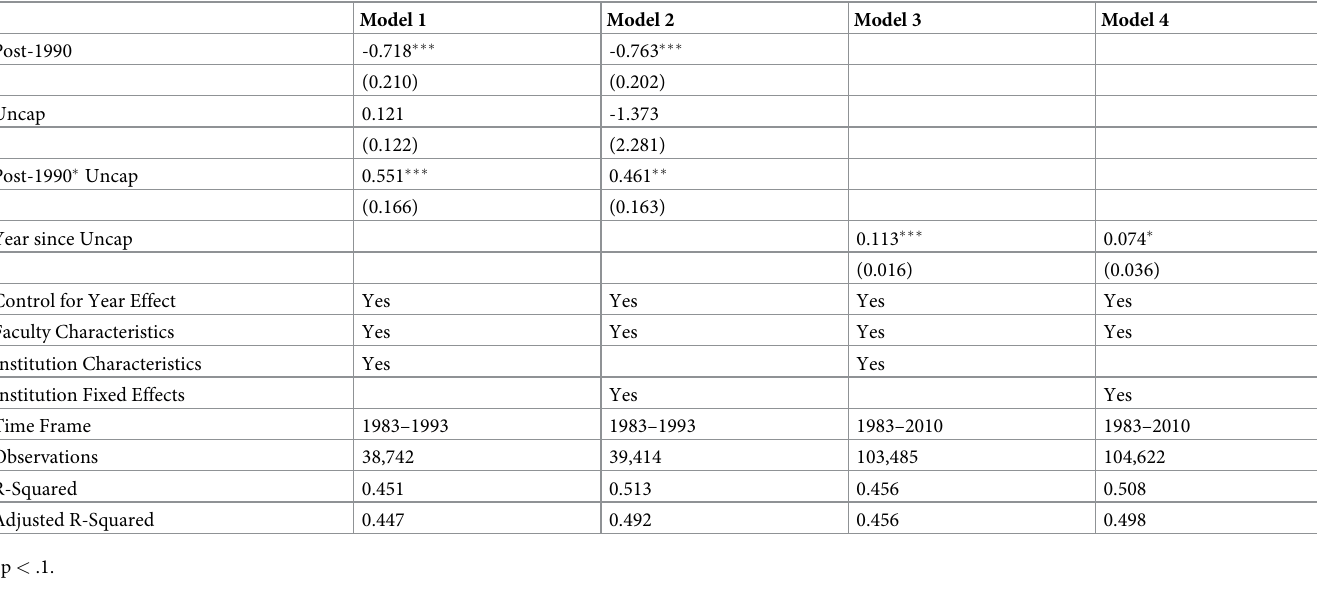
Table 3. Regression results for the impact of elimination of the mandatory retirement policy on the age of tenure-track